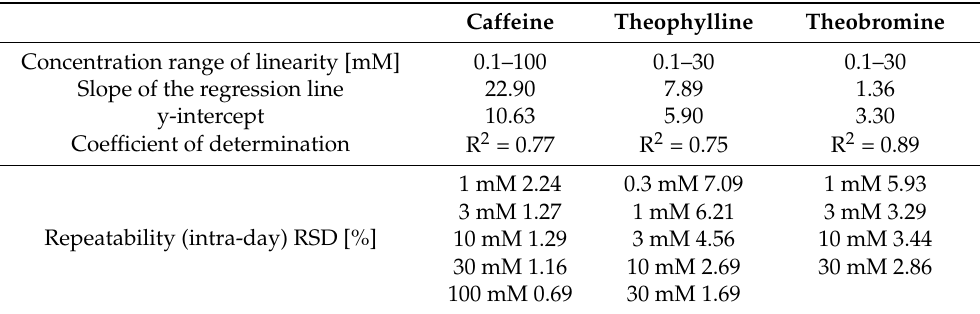
Table 6. Linearity and repeatability (intra-day) RSD of the taste sensor with 3 mM TDAB